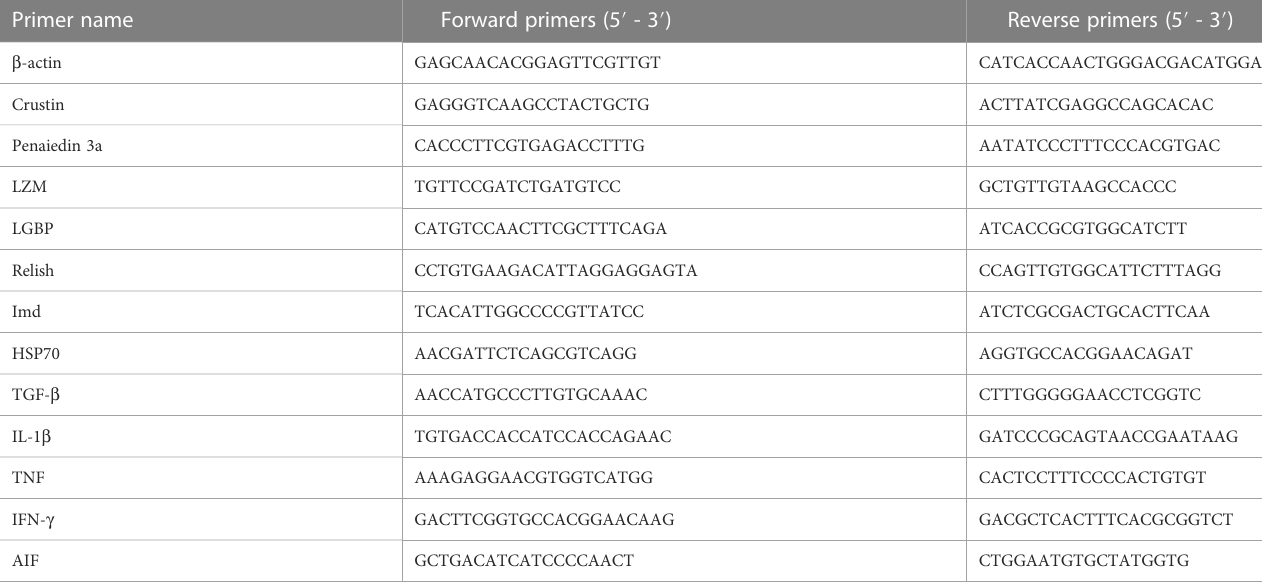
TABLE 2 The primers for quantitative real-time